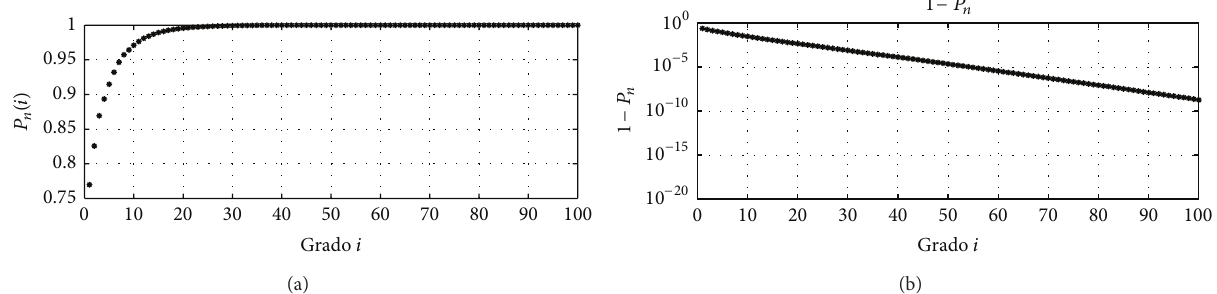
Figure 6: Logarithmic plot of 𝑃 𝑛 and 1 − 𝑃 𝑛 for determining the truncation degree of the POD basis vectors in the reactor case.